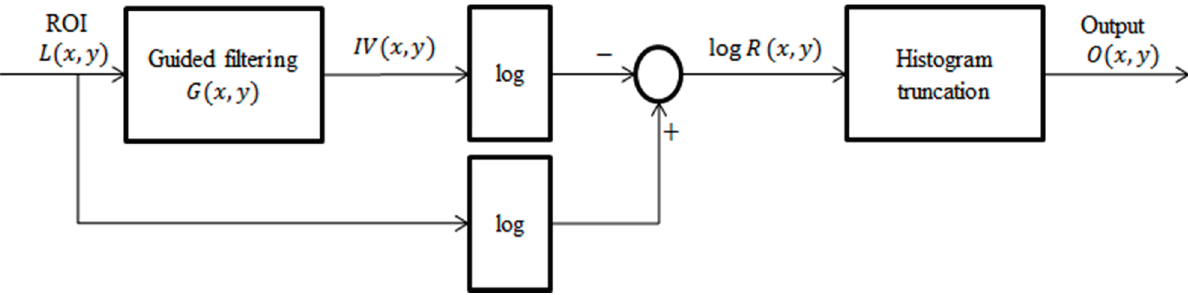
Figure 7. Block diagram of the proposed GFSSR